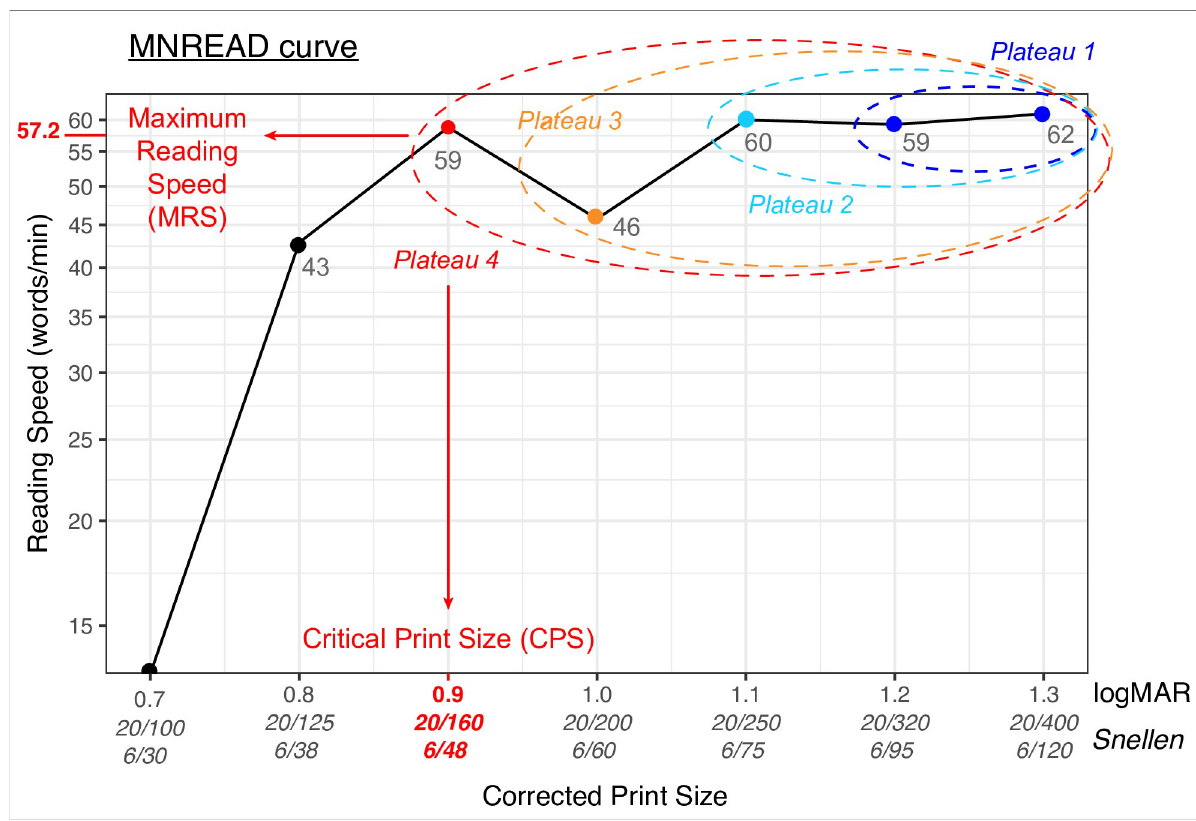
Fig 2. Example of the standard deviation algorithm calculation on a typical MNREAD curve. On iteration 1 (dark blue), the algorithm selects the first two sentences as plateau 1 (x-axis: 1.3 and 1.2 logMAR) and calculates a selection criterion for this plateau. Criterion plateau 1 = mean (reading speed plateau 1 )– 1.96 x standard deviation (reading speed plateau 1 ) = 60.5–1.96 × 2.1 = 56.3 wpm. The point adjacent to plateau 1 (x-axis: 1.1 logMAR) was read at 60 wpm, which is faster than criterion plateau 1, indicating that this point belongs to the optimal plateau. A second iteration is then launched (light blue) with plateau 2 now encompassing the first three sentences and a new criterion calculation. Criterion plateau 2 = 60.3–1.96 × 1.5 = 57.3 wpm. Among the points adjacent to plateau 2 , there is still a value higher than this criterion (y-axis: 59 wpm at x-axis : 0.9 logMAR), so the algorithm continues to iterate one sentence at a time, including reading speeds at 1.0 logMAR in plateau 3 and at 0.9 logMAR in plateau 4 . The calculations stop with plateau 4 , for which selection criterion is higher than any remaining points (criterion plateau 4 = 44.7 wpm). MRS is estimated as 57.2 wpm and a corresponding CPS of 0.9 logMAR.